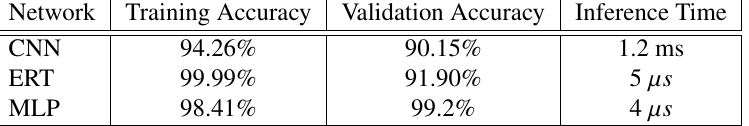
Table 1. Performance of the three Neural Networks investigated for track classification. Namely,